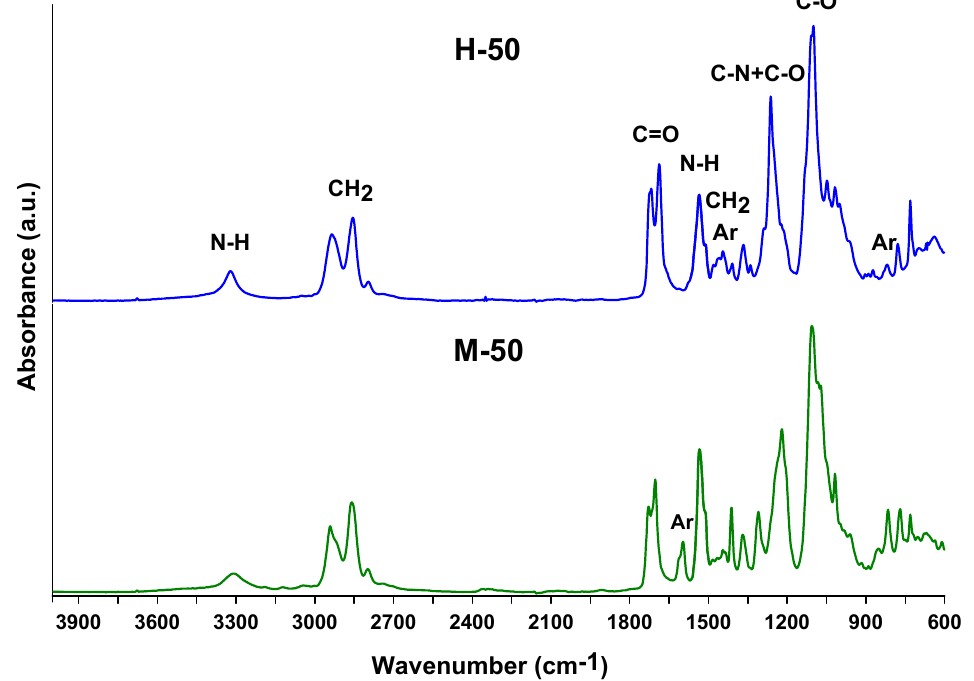
Figure 2. ATR-FTIR spectra of the H-50 and M-50 TPU elastomers.